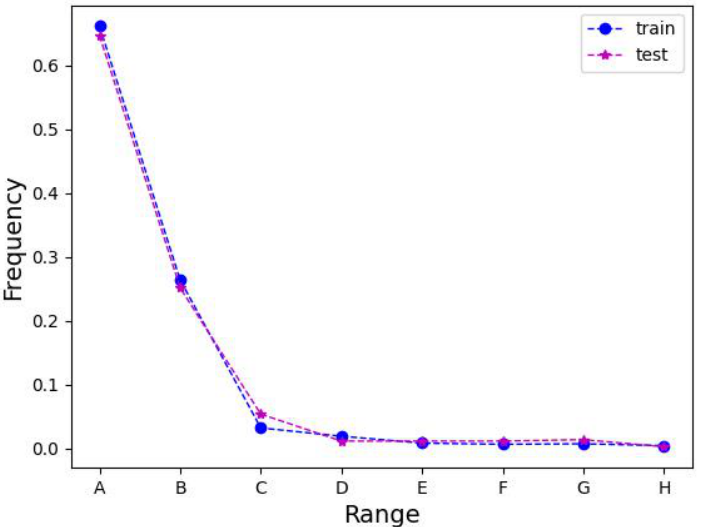
Figure 11. The folding chart of the percentage of different regions in the WHU-CD dataset.